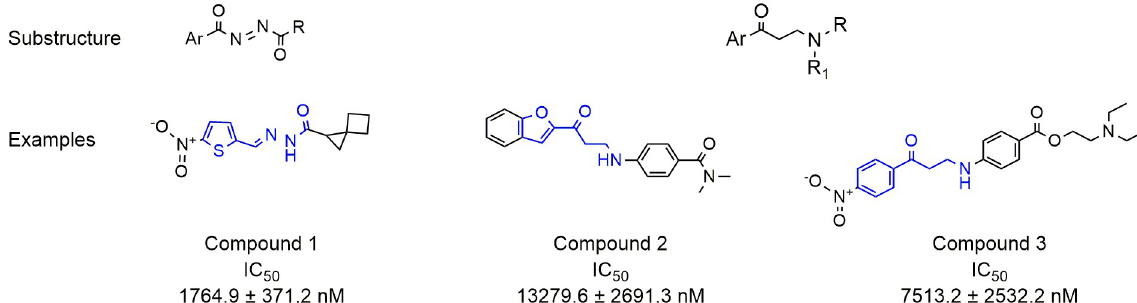
Fig 5. General structures of the two major hit series (substructures). Representative molecules for both series with TR inhibition potency data (examples).